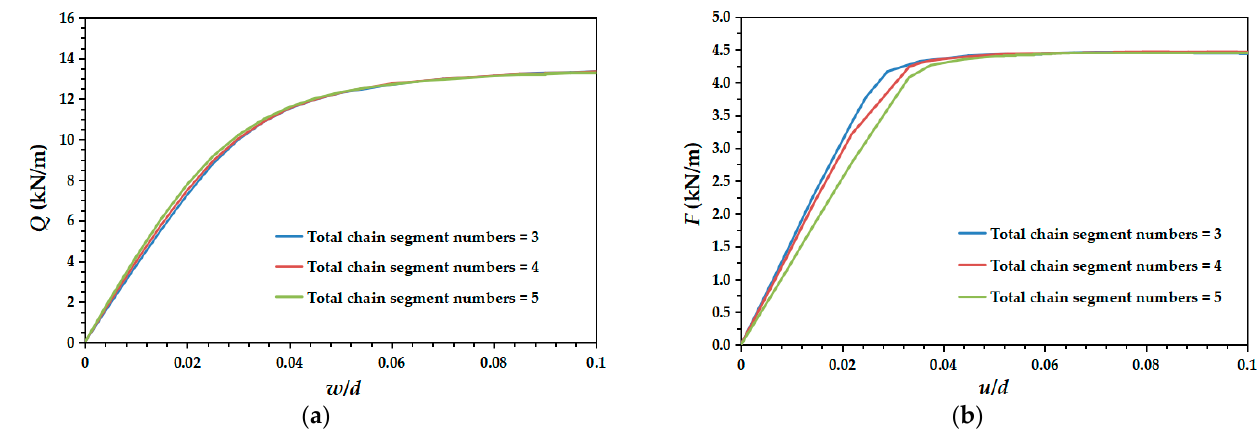
Figure 4. In fl uence of the number of chain segments used: ( a ) normal resistance; ( b ) tangential resistance.